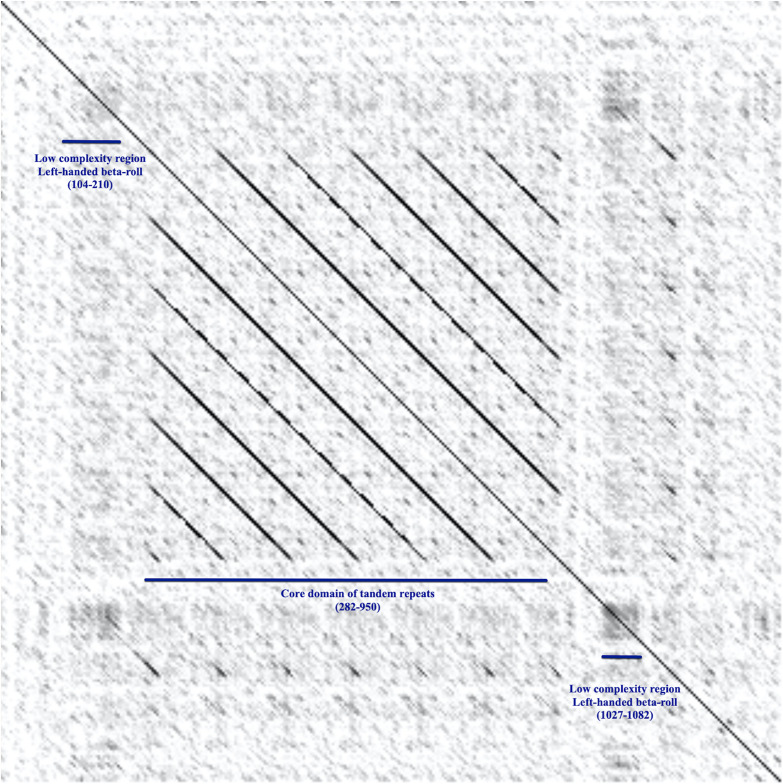
The dot-plot matrix, alignment of BatA against itself. The plot displays the alignment of the BatA amino acid sequence against itself. The horizontal and vertical axes are both the BatA amino acid sequence. The plot shows how the sequence matches to itself, therefore represents the repeat modules and low complexity regions. Each pixel corresponds to a residue in the horizontal and vertical sequences. The pixel shading represents the score of matching the residues; the darker the pixel, the higher the score. In the middle of the sequence, there is a core domain of tandem repeats, which is repeated six times within the sequence (282–950). The low complexity regions stand out as black squares.